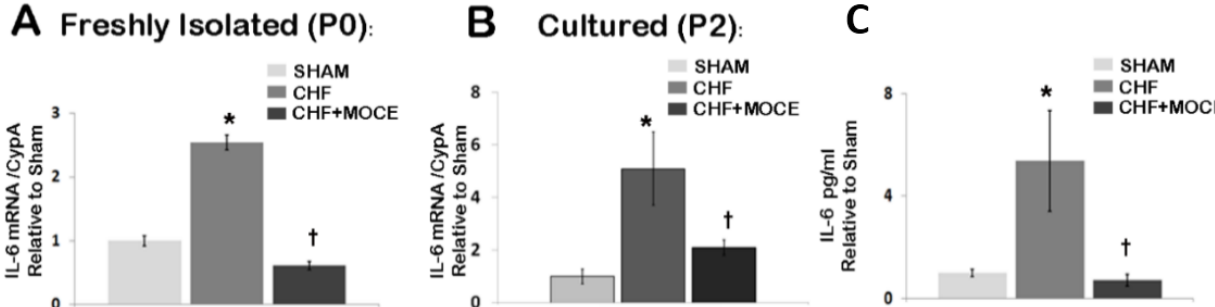
Figure 6. Mocetinostat reduced IL-6 level in cardiac fibroblasts. ( A ) Levels of IL-6 mRNA were measured in CD90 + fibroblasts isolated from sham, untreated and Mocetinostat treated CHF ventricles directly after isolation without culturing (P0) and ( B ) at P2 after culture; ( C ) ELISA was performed to measure levels of IL-6 in conditioned media of CD90 + fibroblasts isolated from sham, untreated and Mocetinostat treated CHF ventricles. Error bars indicate SE. ( n = 5); * , p < 0.05 compared to shams; †, p < 0.05 compared to untreated CHF; CHF, congestive heart failure; MOCE,